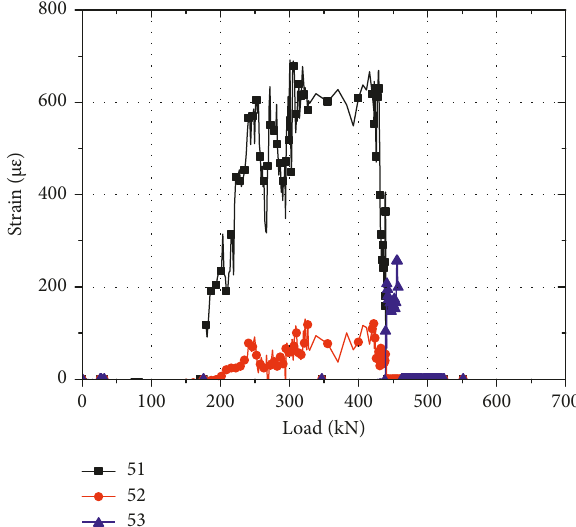
Figure 18: The strain results of bent bars in P2 specimen.